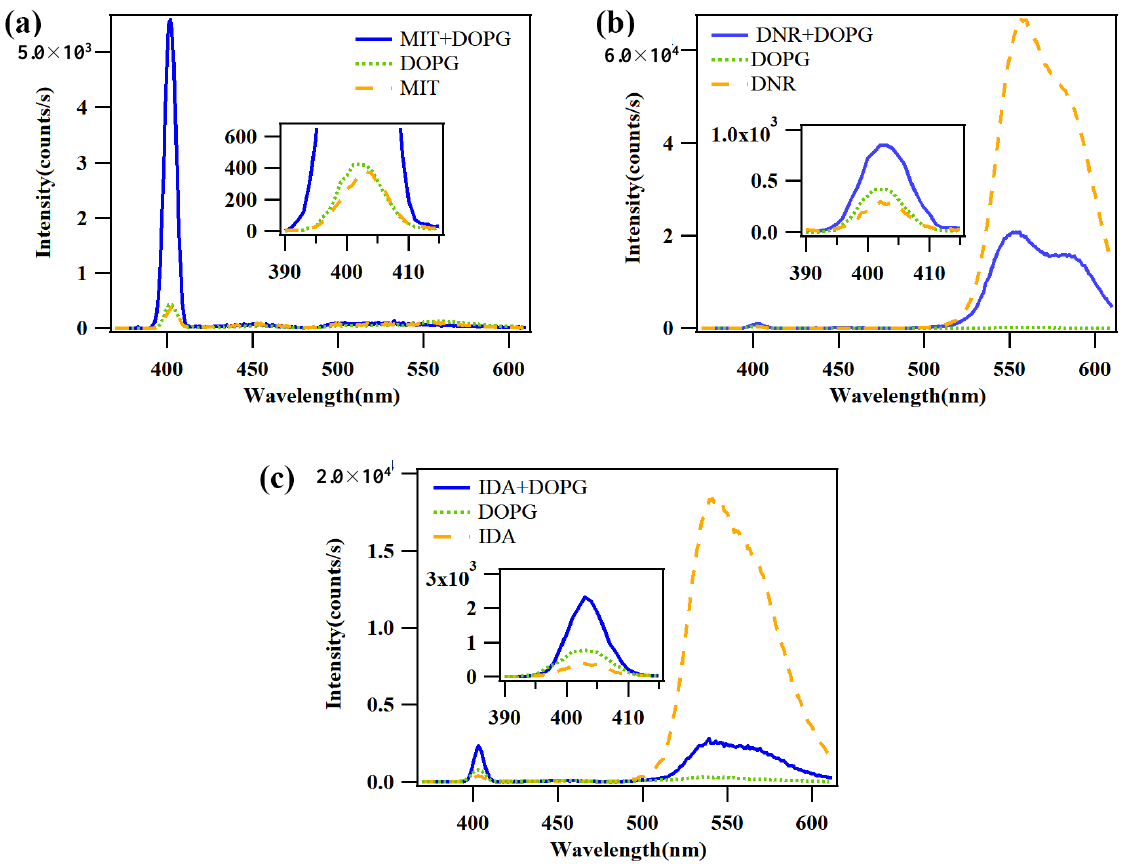
Figure 9. The scattering spectra from the MIT ( a ), DNR ( b ), IDA ( c ) solutions (20 µ M, dashed line), DOPG vesicle solution (250 µ M, dotted line), and the mixture solutions of DOPG vesicles and anthracyclines at their respective concentrations (solid line). Reproduced with permission [58]. Copyright 2020 Elsevier.